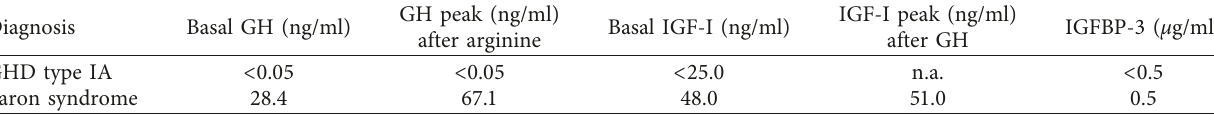
Table 3: Biochemical parameters of the two patients at the time of